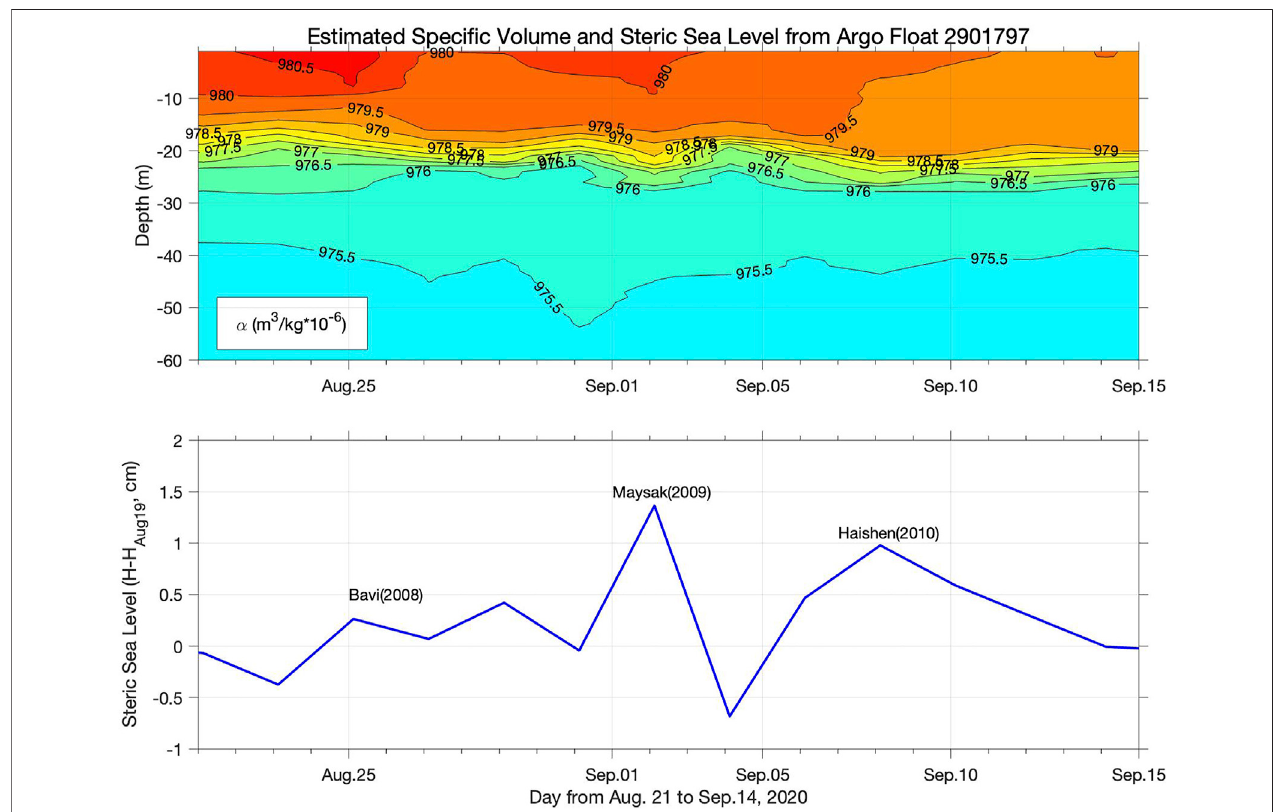
FIGURE 7| Calculated speci fi cvolumeof sea water and the steric sea level change from August 21 toSeptember 14, 2020. The steric sea level wascalculated as the height relative to the value of 19 August 2020.